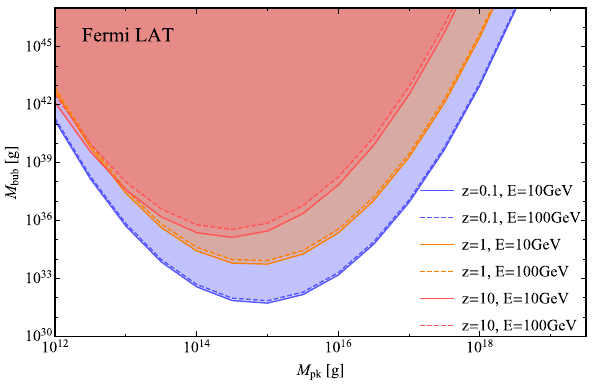
Fig. 3 The parameter space of the peak mass M pk and bubble mass M bub of a PBH bubble allowed by Fermi LAT (the shaded regions) for redshifts z = 0 . 1 , 1 , 10 and photon energies E = 10 , 100 GeV, respectively